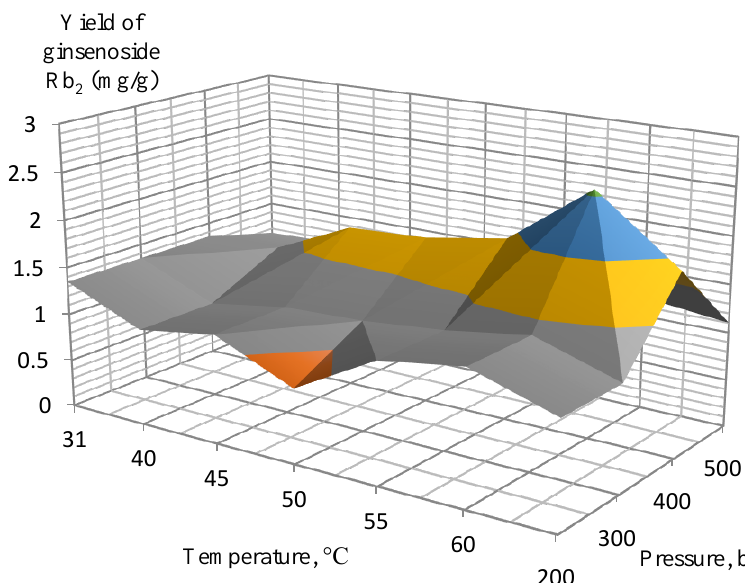
Figure 2. Orthogonal projection representing the results of extraction of ginsenoside Rb 2 at 200 to 500 bar and 3.4% EtOH co-solvent.